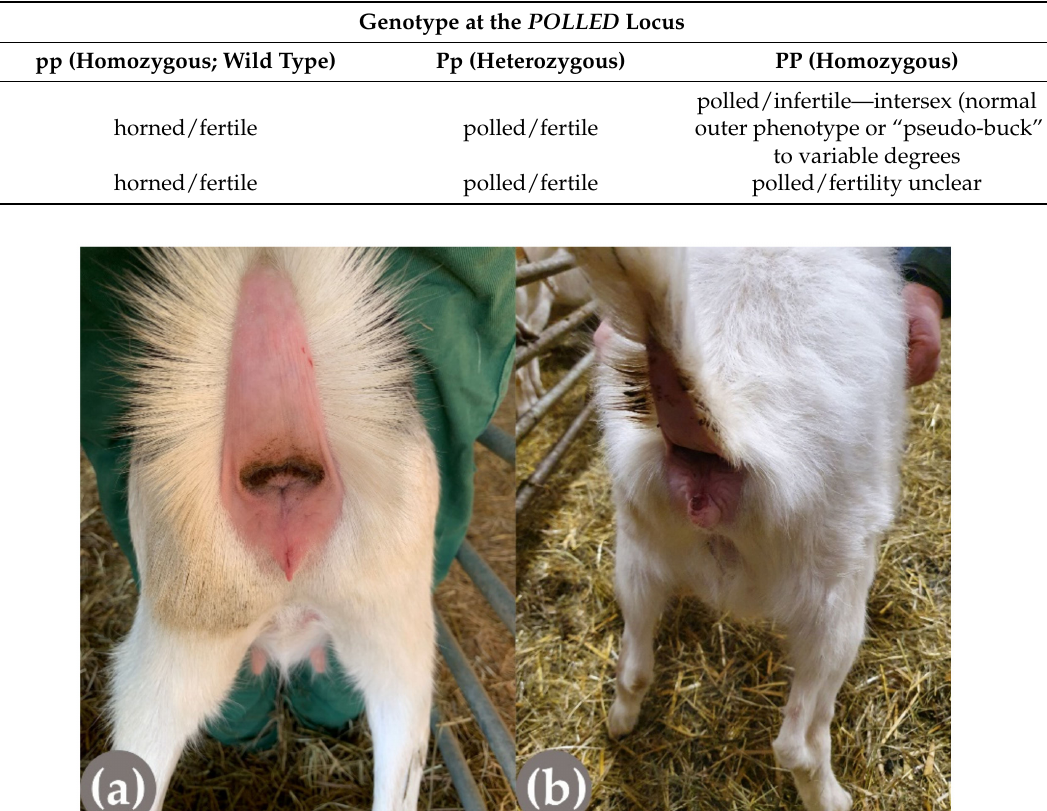
Table 1. Impact of the caprine POLLED allele on horn status and the fertility of female (XX) and male (XY) goats.